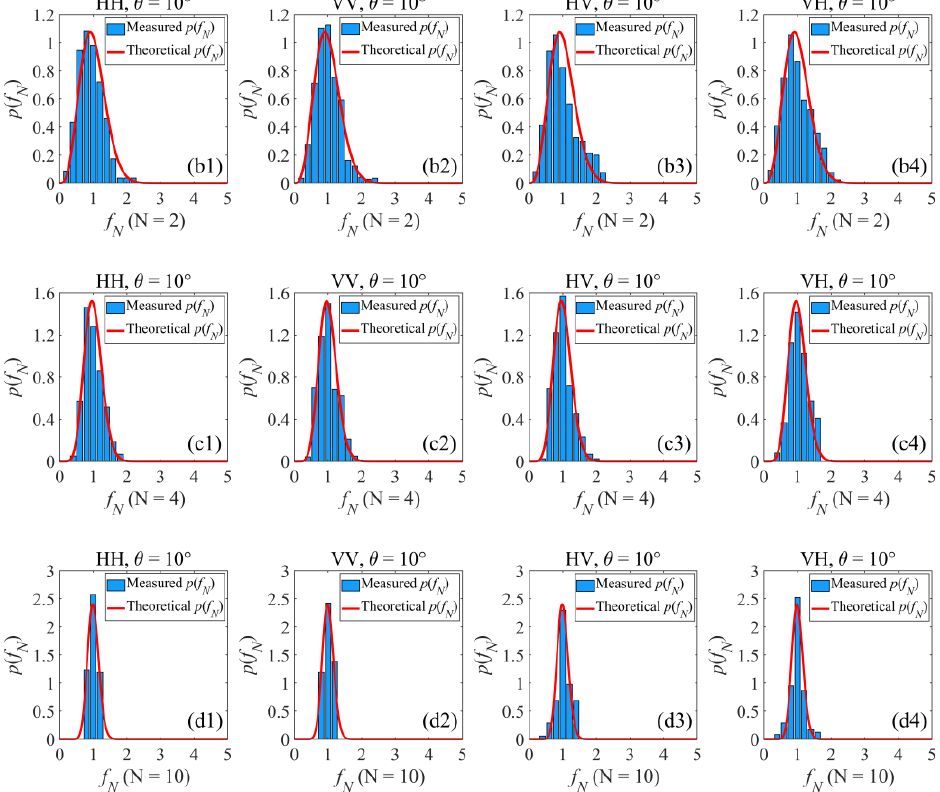
Figure 9. Measured and theoretical PDFs of the backscatter from rice field Scene 2 with full-polarization at an incidence angle of 10 ◦ for linear detection when ( a1 – a4 ) N = 1; ( b1 – b4 ) N = 2; ( c1 – c4 ) N = 4; ( d1 – d4 ) N = 10.